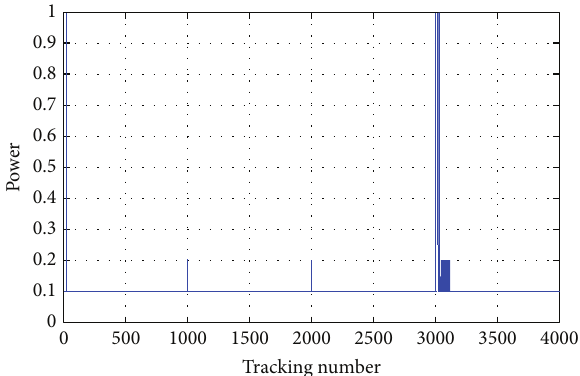
Figure 12: Variation of variable fractional-order differentiator 𝛼 .